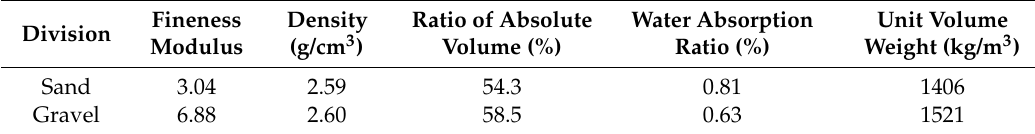
Table 5. Properties of admixture.